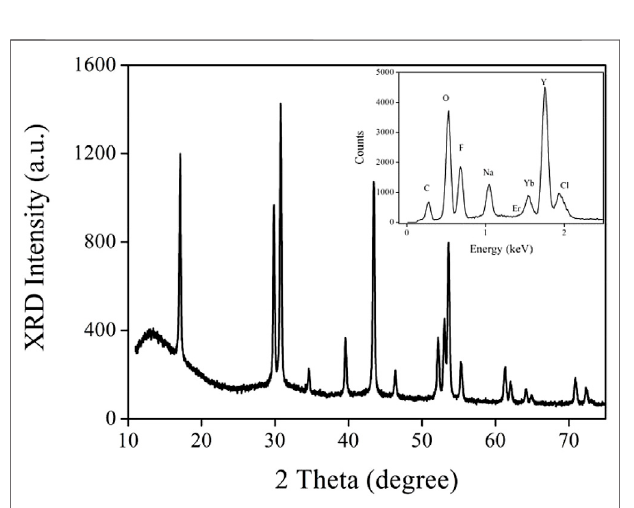
FIGURE 3 | IR spectra of free α -CD and our excitation lattice before and after α -CDmodi fi cation.Inset:photosofourexcitationlatticeinhexane/water- mixed solvent before and after α -CD modi fi cation ( λ ex = 980